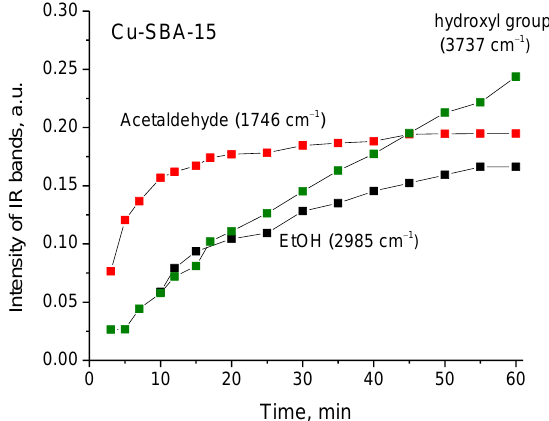
Figure 6. Changes in the intensity of IR bands in the spectra recorded for Cu-SBA-15 catalyst in ethanol flow at 593 K during 60 min: EtOH (black), acetaldehyde (red), and consumption of hydroxyl groups (green).